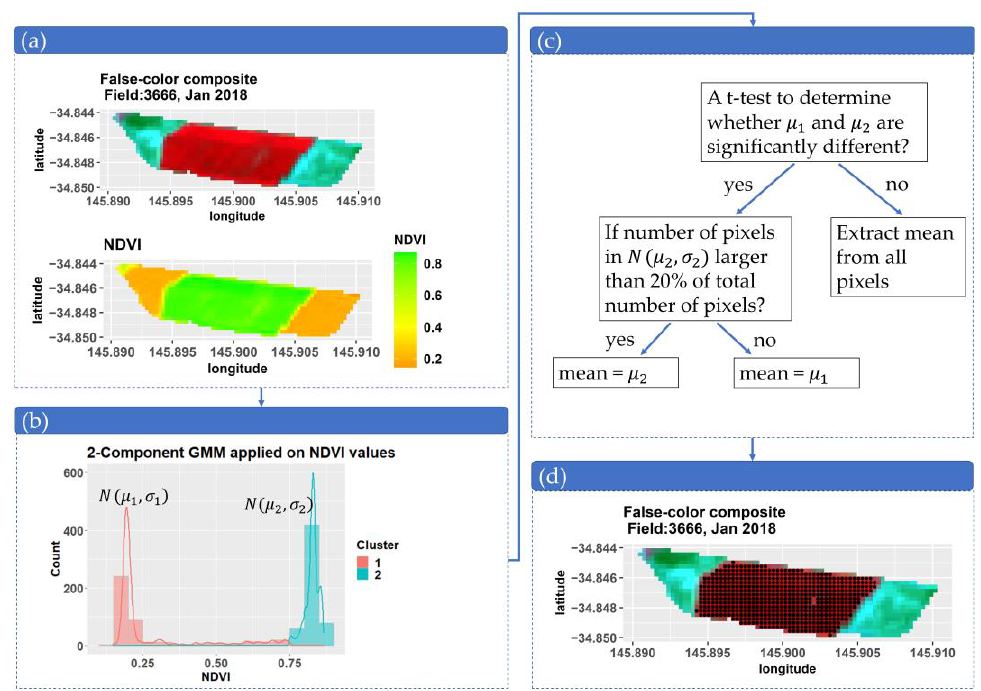
Figure 4. The flowchart of the GMM-based filtering method. ( a ) Field conditions; ( b ) applying 2- component GMM on NDVI values; ( c ) the GMM decision tree; and ( d ) final results (the representative pixels were shown with black dots).